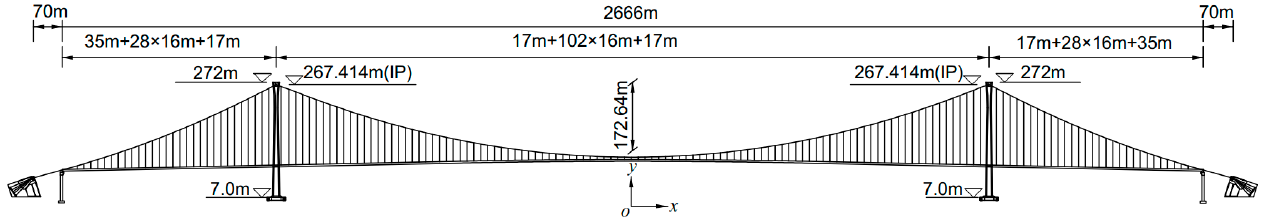
Figure 4. Layout of the suspension bridge using parallel main cables.